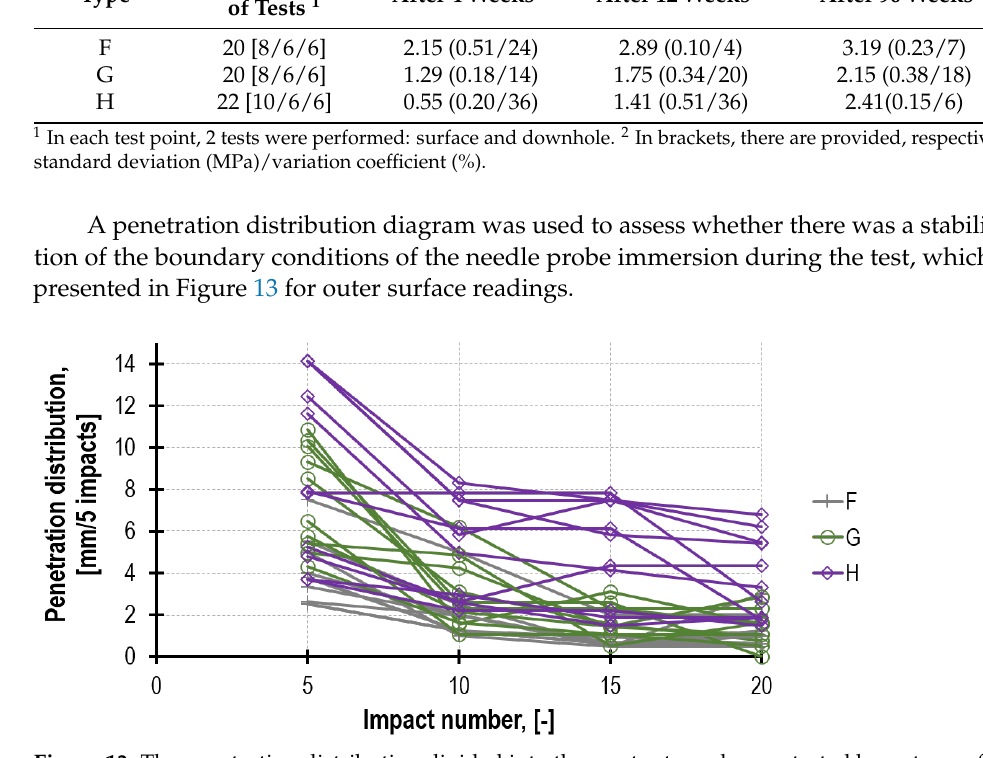
Table 5. Mortar PT strength f m.PT in MPa—an average value from the surface and downhole mea- surements (after deepening the hole with a drill).